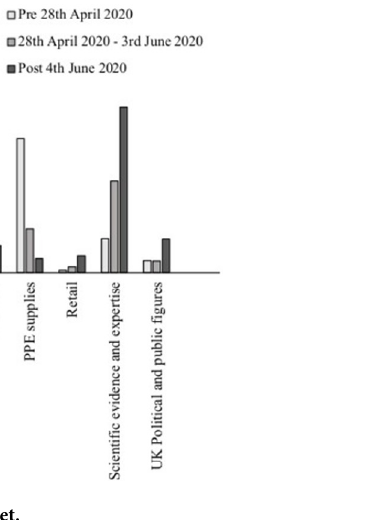
Fig 1. Subject categories in the ‘most retweeted tweets’